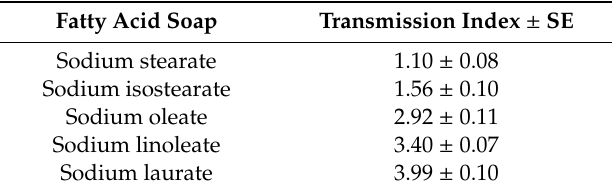
Table 1. Transmission index (TI) value of each